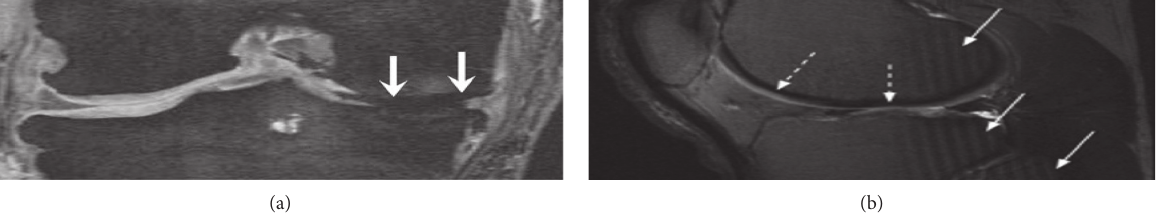
Figure 3: Artifacts in knee magnetic resonance image: (a) susceptibility and (b) artifacts produced by chemical (dashed arrow) and variation artifact (arrow) (reproduced from reference